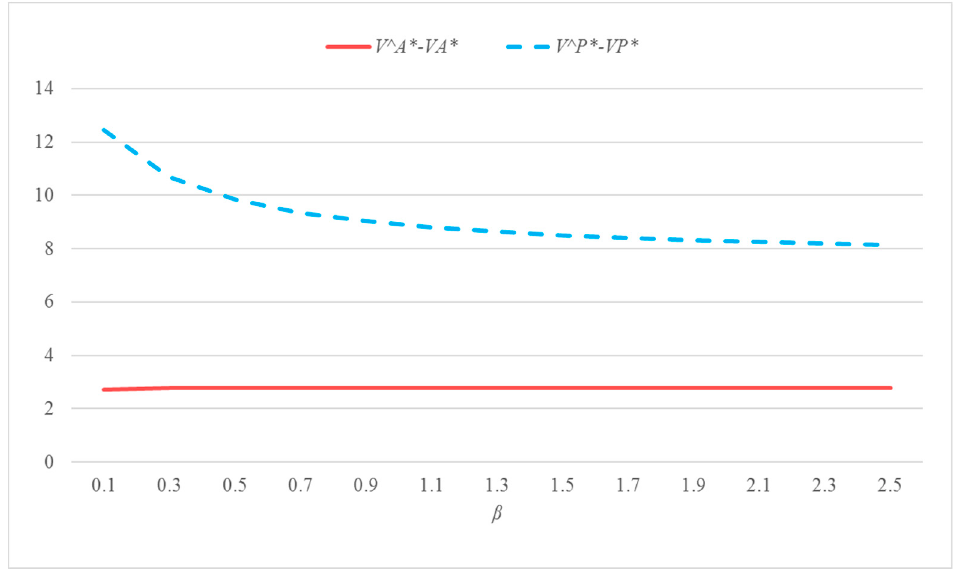
Figure 6. Part (v): ˆ V ∗ and ˆ V ∗ . Notes: Figure 6 is generated based on P = 10, µ 1 = 0.1, µ 2 = 0.3, θ 1 = 0.1, θ 2 = 0.4, δ = 0.4, α = 0.3, η 1 = 0.3, η 2 = 0.3, λ = 0.4, ρ = 0.3, R 0 = 20, and G 0 = 200.